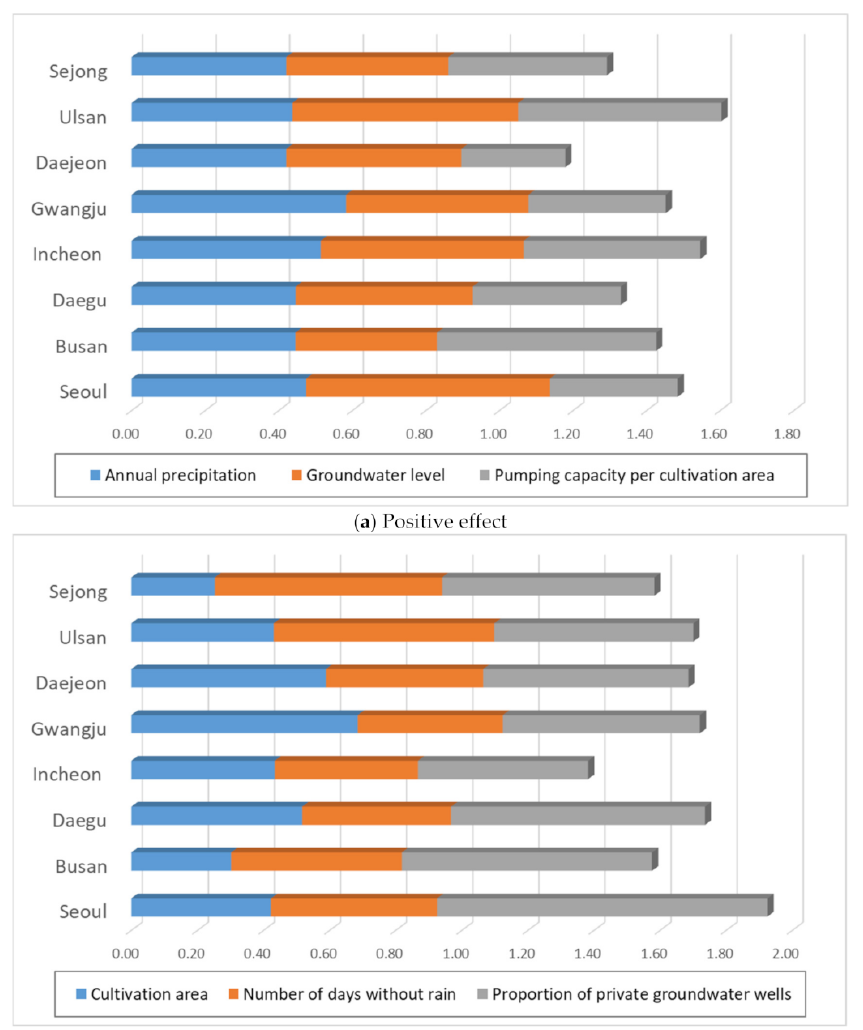
Figure 4. Evaluation factor data for metropolitan cities ( a ) Positive effect and ( b ) Negative